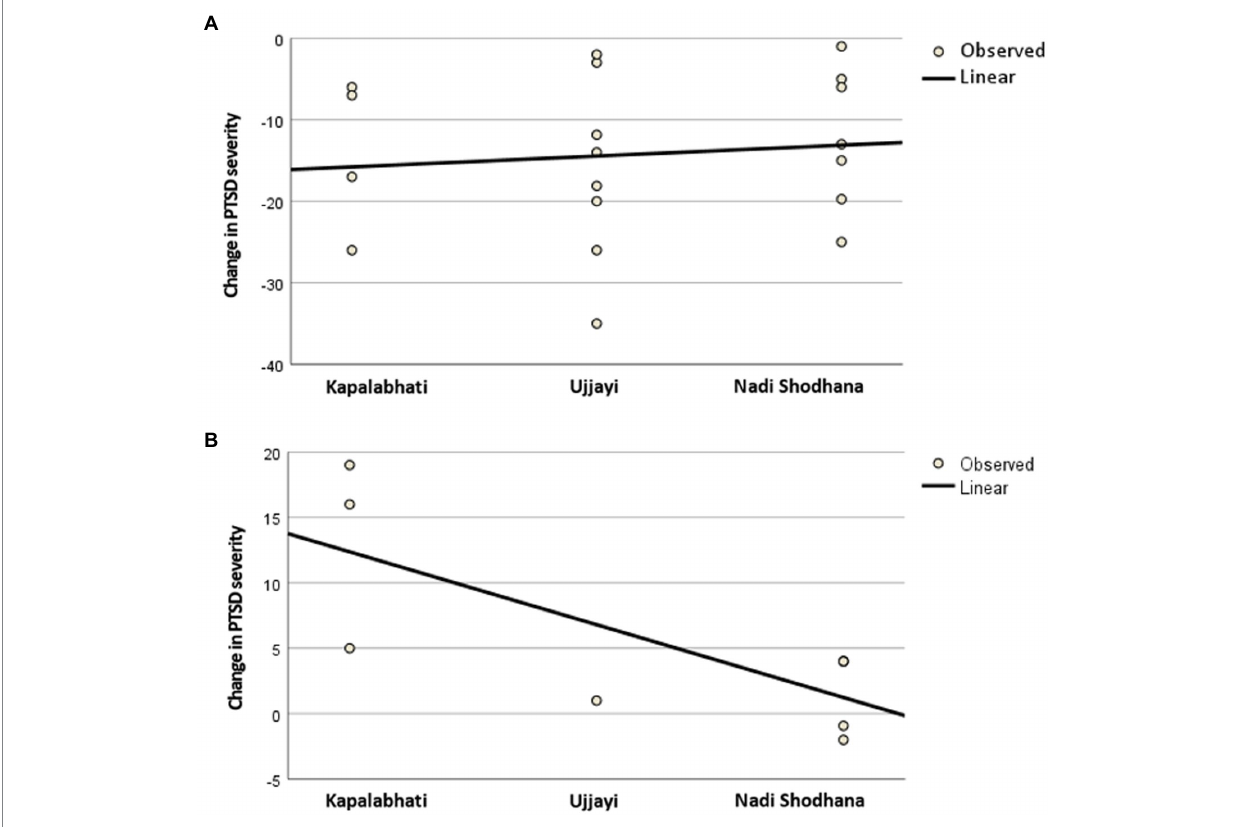
FIGURE 2 Results of the linear regression analysis for (A) patients without recurrent adverse events during pranayama and for (B) patients with recurrent adverse events during pranayama. PTSD = Post-traumatic stress disorder.